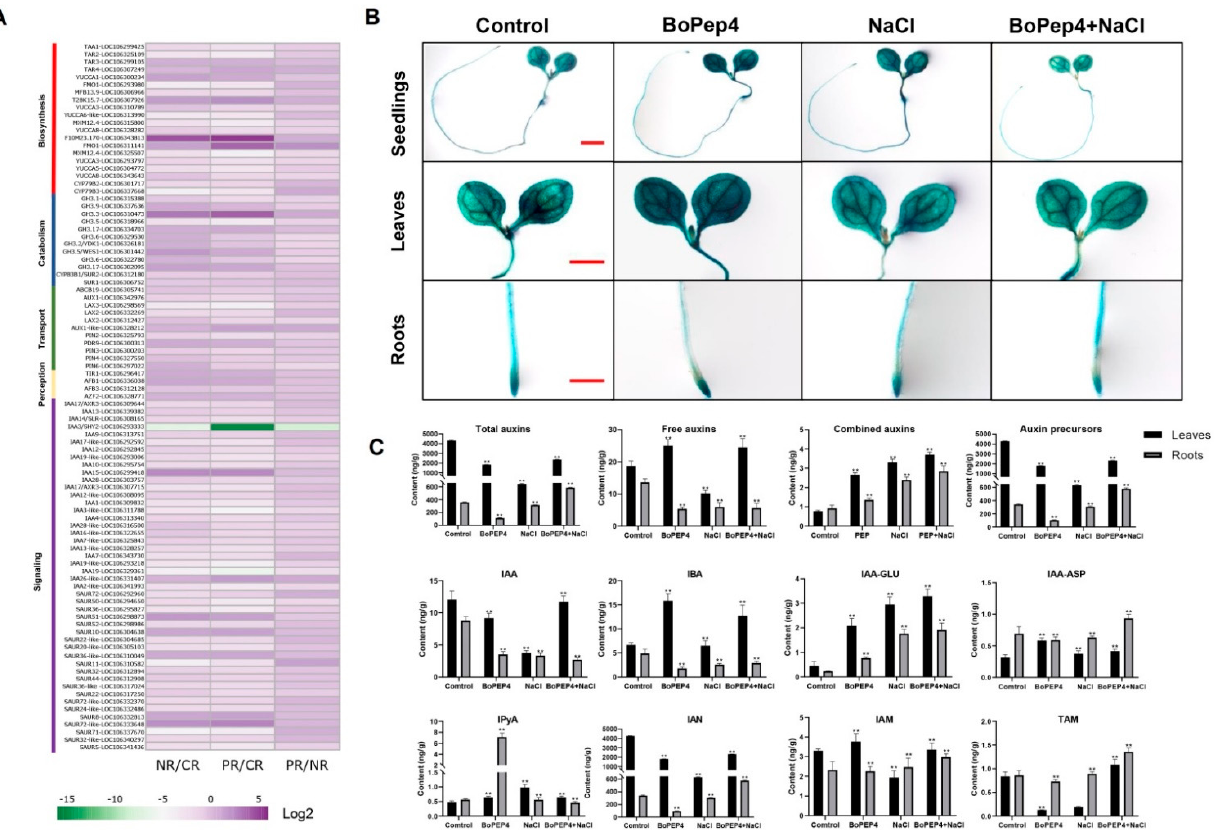
Figure 5. BoPEP4 treatment alters auxin accumulation under salt stress. ( A ) The expression of the genes associated with auxin biosynthesis, metabolism, transport, perception, and signaling in CR, PR and NR analyzed by RNA sequencing. The detailed expression data are available in Table S5. ( B ) Histochemical staining for GUS activity of Arabidopsis seedlings transformed with DR5::GUS under 50 nM BoPep4, 150 mM NaCl and combination treatments. ( C ) Auxin contents of broccoli leaves and roots under 100 nM BoPep4, 200 mM NaCl and combination treatments. Three independent experiments were performed. Error bars indicate SD (** p < 0.01).